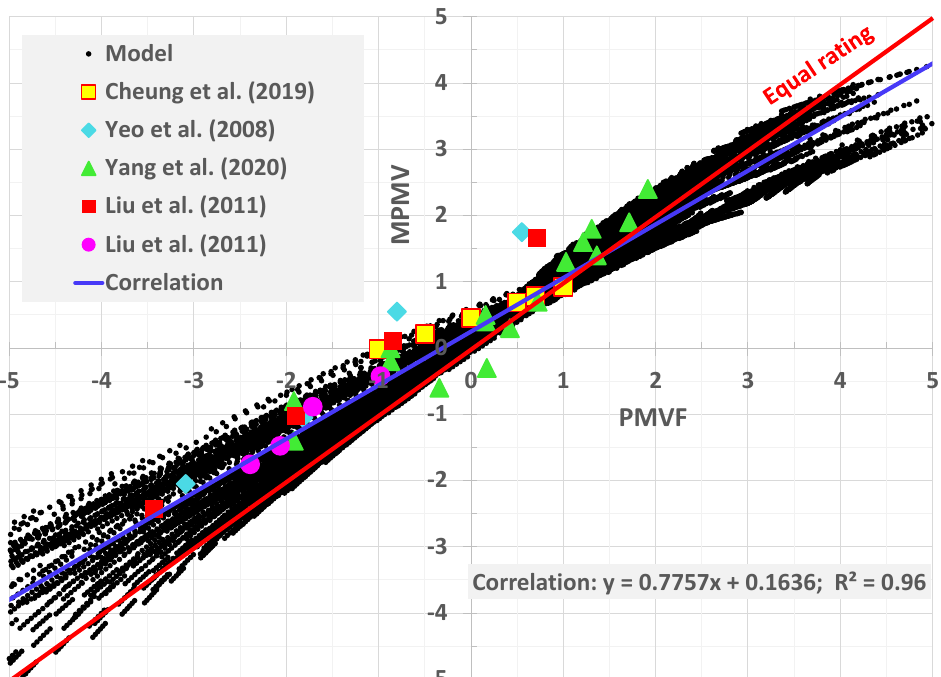
Figure 3. Relationship between MPMV and Fanger’s PMV in typical conditions of built environments (note the included measured data of Cheung et al. [12], Yeo et al. [20], Yang et al. [58], Liu et al. [59], and Liu et al. [60] were not part of the experiments of Table 1 for the model constant derivation).